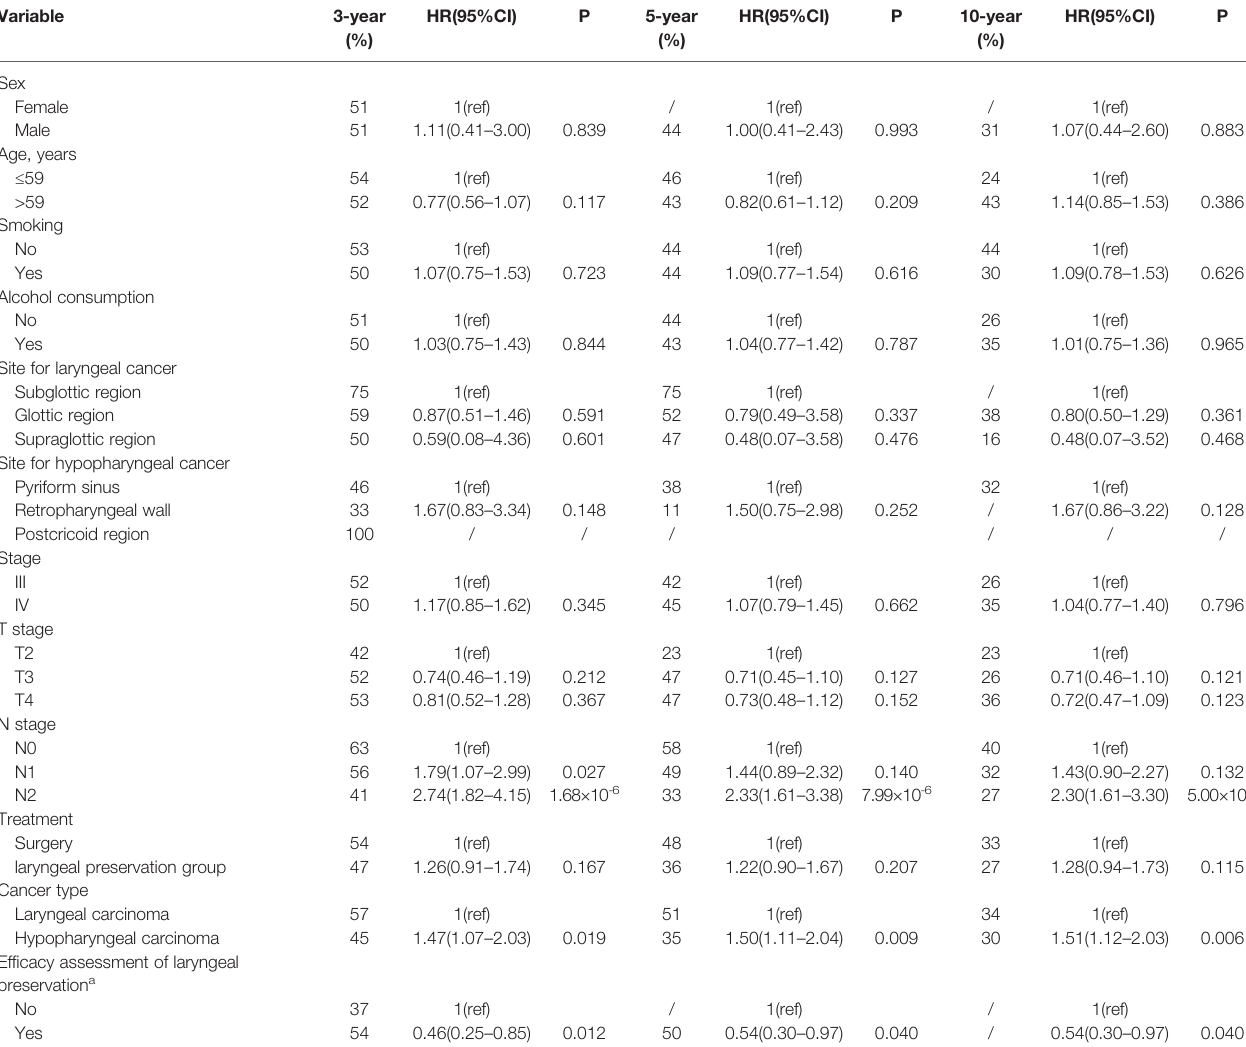
TABLE 2 | Univariate analysis of progression-free survival in patients with laryngeal and hypopharyngeal carcinoma.